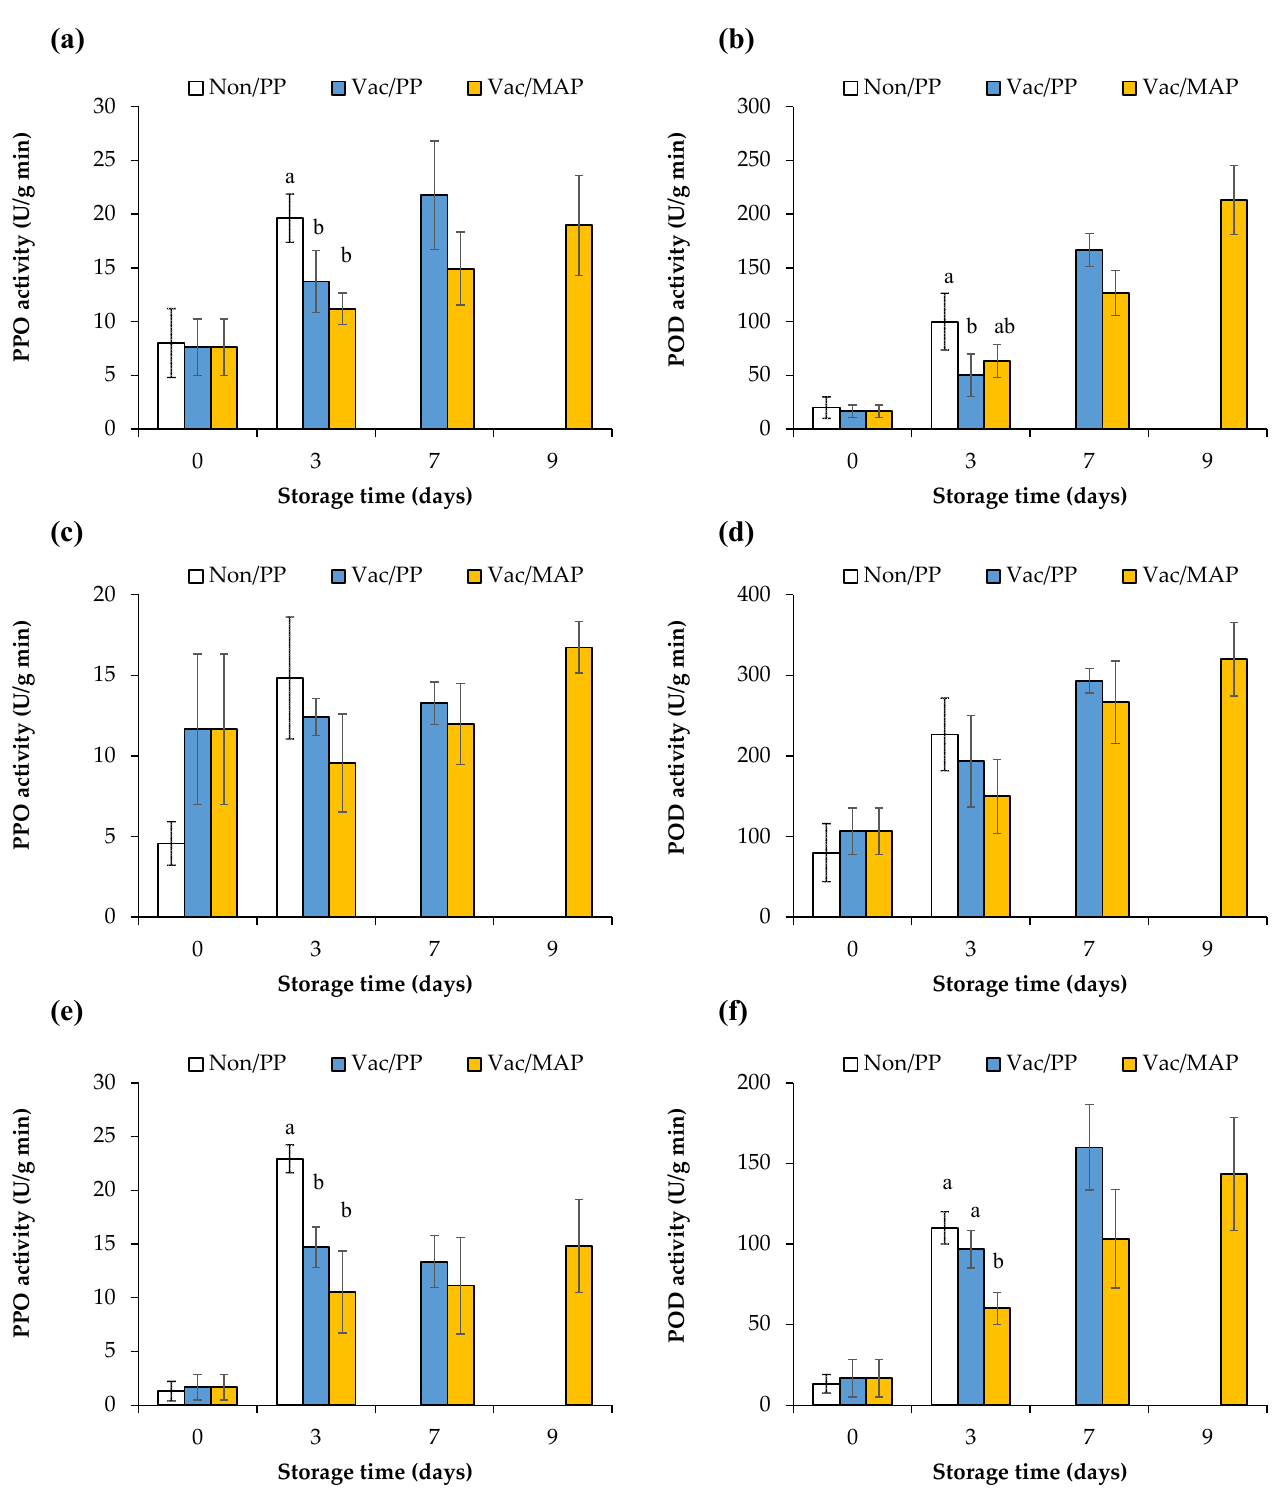
Figure 7. Changes in the activity of PPO ( a , c , e ) and POD ( b , d , f ) in fresh-cut vegetables consisting of frillice iceberg ( a , b ), romaine ( c , d ), and red oak leaf ( e , f ) lettuce, during storage at 4 °C. Error bars represent the mean of three replicates ± SD.